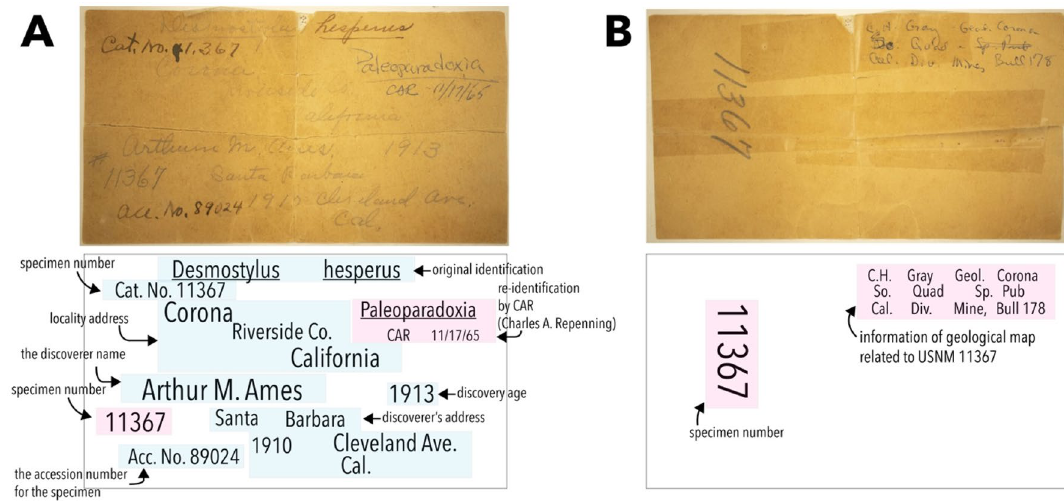
Figure 1. The original label of USNM PAL V 11367. ( A ) A front side; ( B ) a backside. Blue masked areas are old descriptions, and pink areas were presumably added later. In addition, “ACC (accession number) No. 89024” was also written on the label, but we could not identify its meaning. This label is also housed in the National Museum of Natural History, Smithsonian Institution (Washington DC,